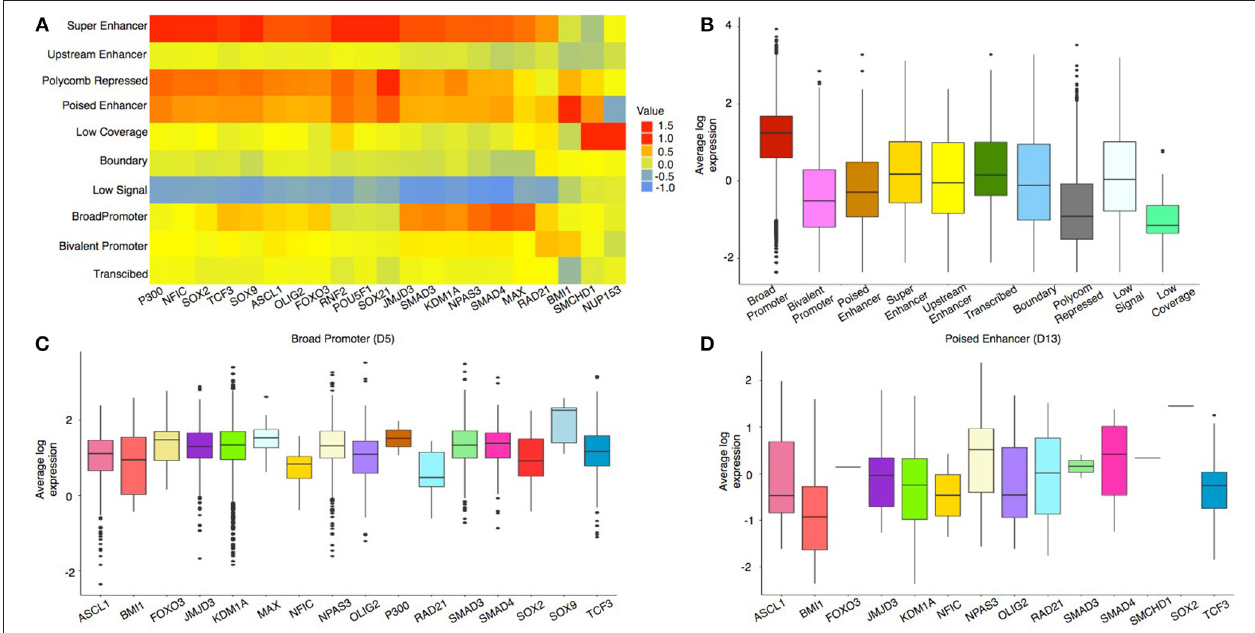
FIGURE 3 | (A) Enrichment (in log scale) of TF peaks in different chromatin states showing binding preference of individual TFs. (B) Comparison of average TPM expression (in log scale) of proximal genes ( ± 2 kb from TSS) in different domain level chromatin states. Genes were mapped to the nucleosome-level states for the corresponding domain-level states. (C) Comparison of average TPM expression (in log scale) of proximal genes ( ± 2 kb from TSS) mapped to individual TFs in the Broad Promoter state and in (D) the Poised Enhancer